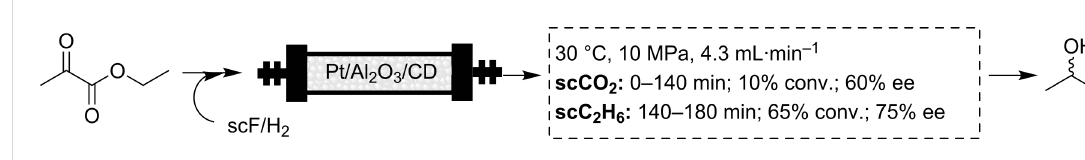
Scheme 1: Hydrogenation of ethyl pyruvate.